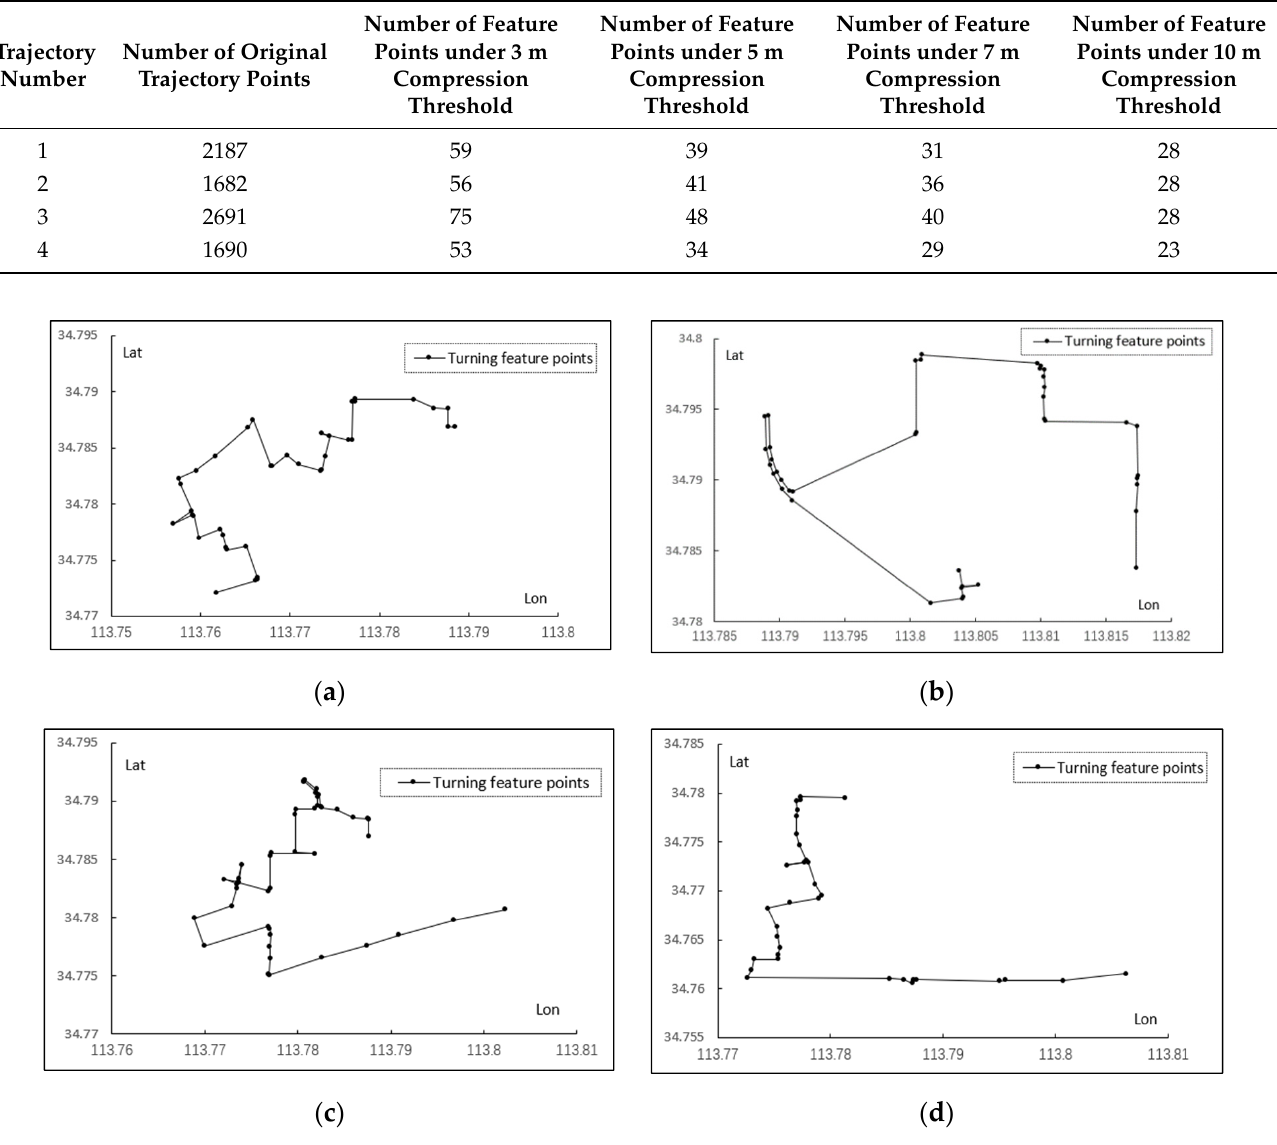
Figure 13. The extraction results of turning feature points under the 5m compression threshold: ( a ) the first example of cycling trajectory; ( b ) the second example of cycling trajectory; ( c ) the third example of cycling trajectory; ( d ) the fourth example of cycling trajectory.